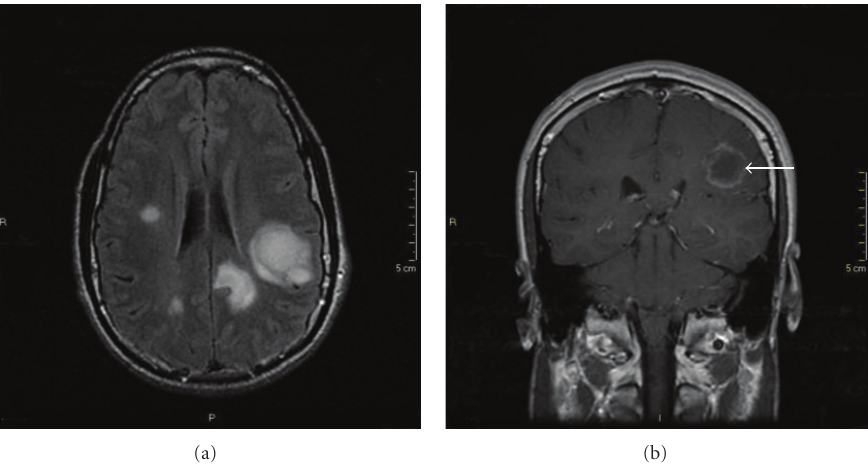
Figure 1: Initial MRI scan of the brain. An axial FLAIR image shows multiple hyperintense bilateral brain masses involving mainly left parietal lobe and splenium of corpus callosum (a). A coronal T1-weighted image (b) obtained after contrast administration shows gadolinium rim-enhancement of the main lesion (arrow).